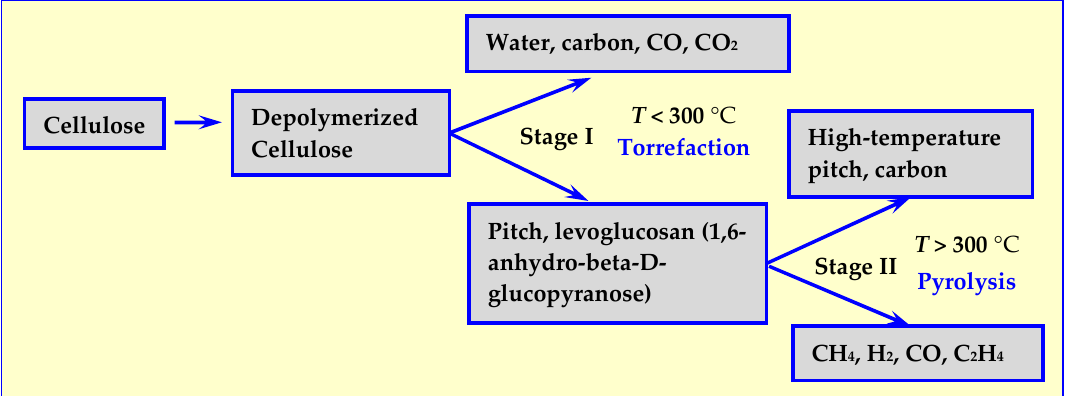
Figure 2. Stages of thermal decomposition of the main component of cellulose biomass [17].